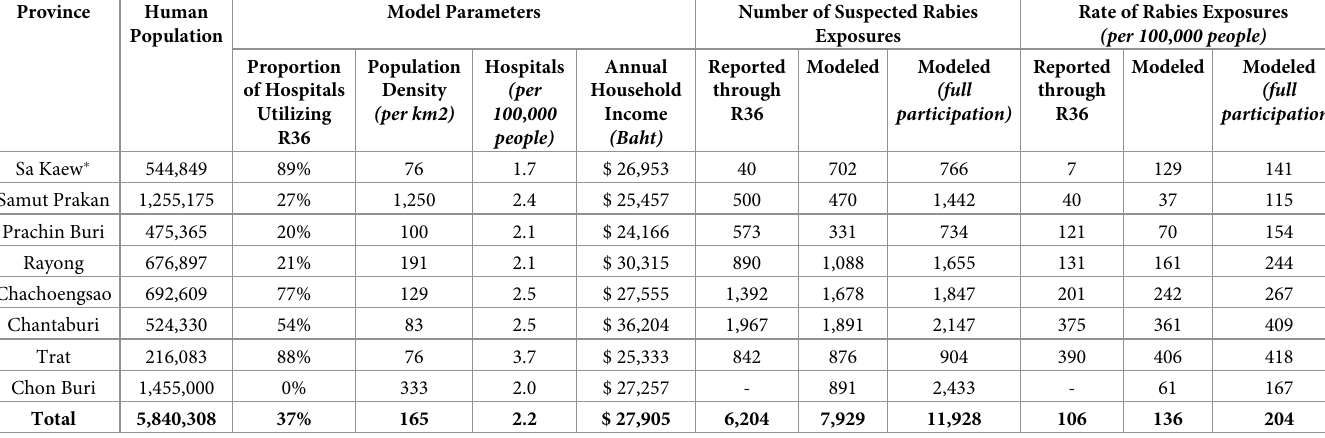
Table 2. Number of suspected rabies exposure that report to R36 and proportion of reported number by province. Province Human Model Population